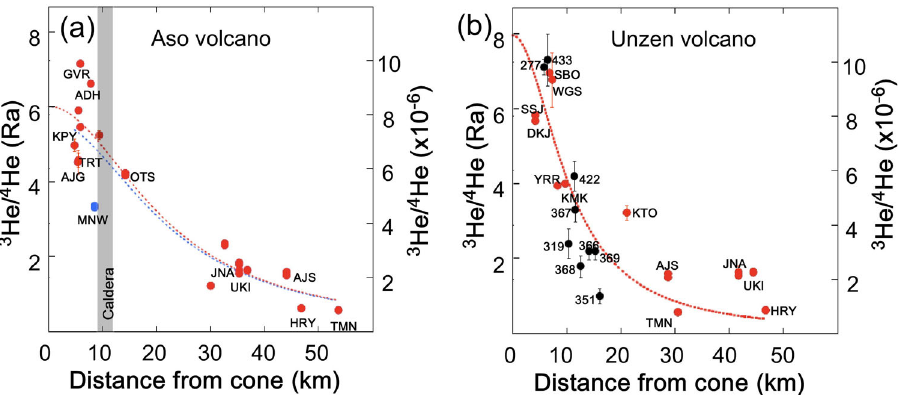
Fig. 2 Relationship between the distance from the volcanic cone to the sampling site and helium isotopes corrected for air contamination. a The relationship from Aso volcano where red and blue circles show water and gas data. Blue circles show exceptionally low helium isotopes at No. 4-MNW. Blue and red dotted curves are the best fi t to the data estimated by the Hydrodynamic Dispersion (HD) model with No. 4 and without No. 4, respectively. b The relationship from Unzen volcano where red and black circles show water and gas data. Black circles data are referred from Morikawa et al. (ref. 14 ) together with data obtained in this work (red circles). Red dotted curve shows the best fi t to the data by the HD model. The Error assigned to the red circle data obtained in this study is 1 sigma (SE), while the error assigned to the black circles was derived from calculations by Morikawa et al. (ref. 14